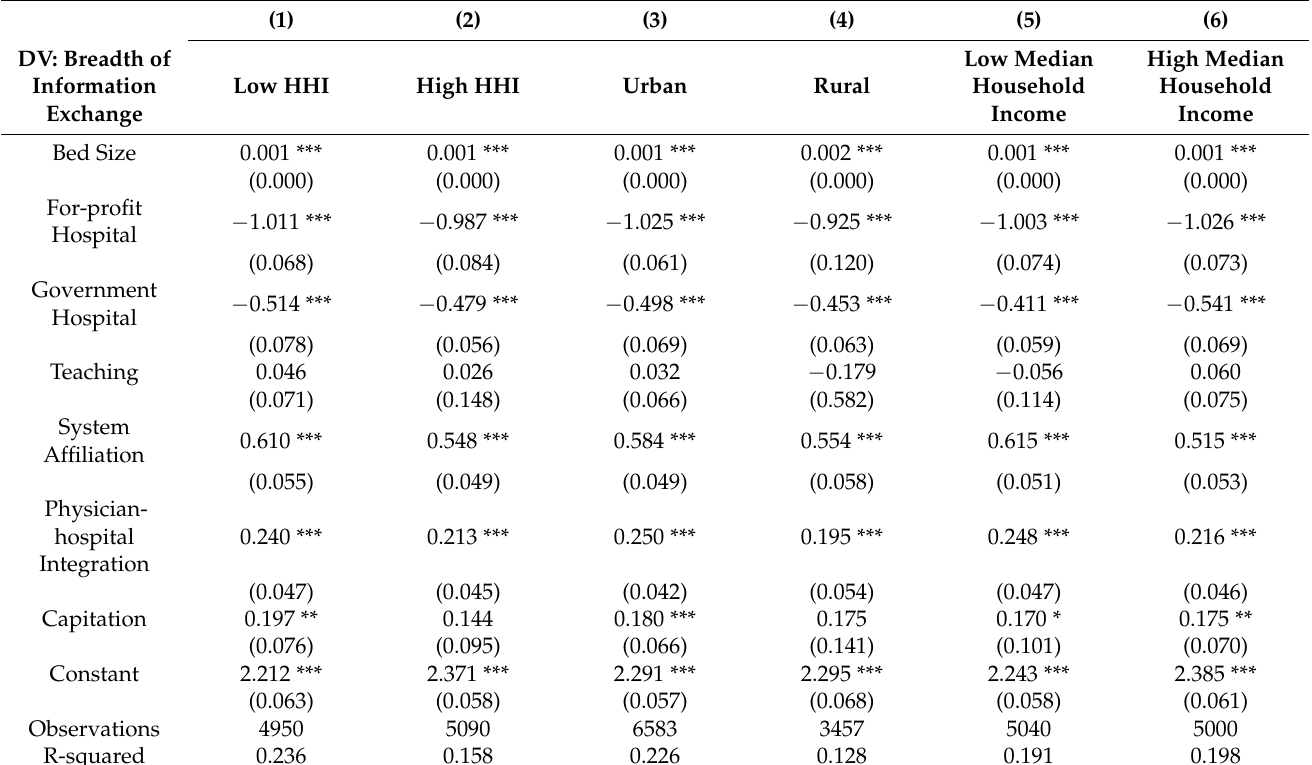
Table 3. Sub-sample Analysis—Breadth of Information